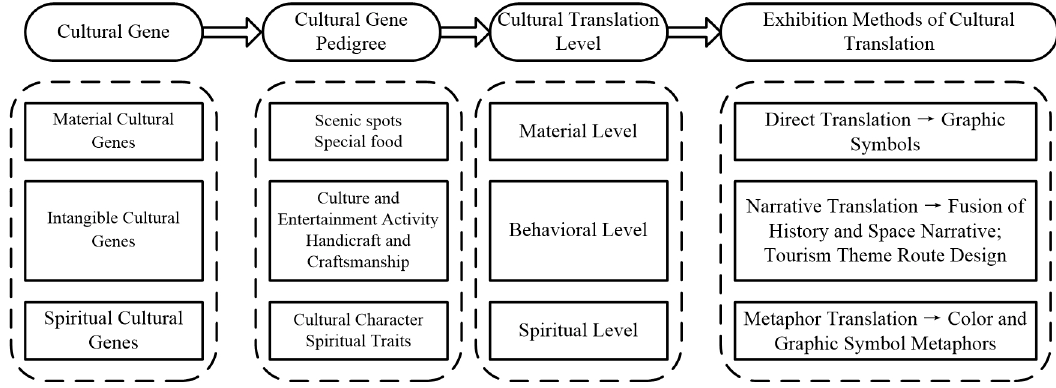
Figure 2. Cultural pedigree and translation methods for regional